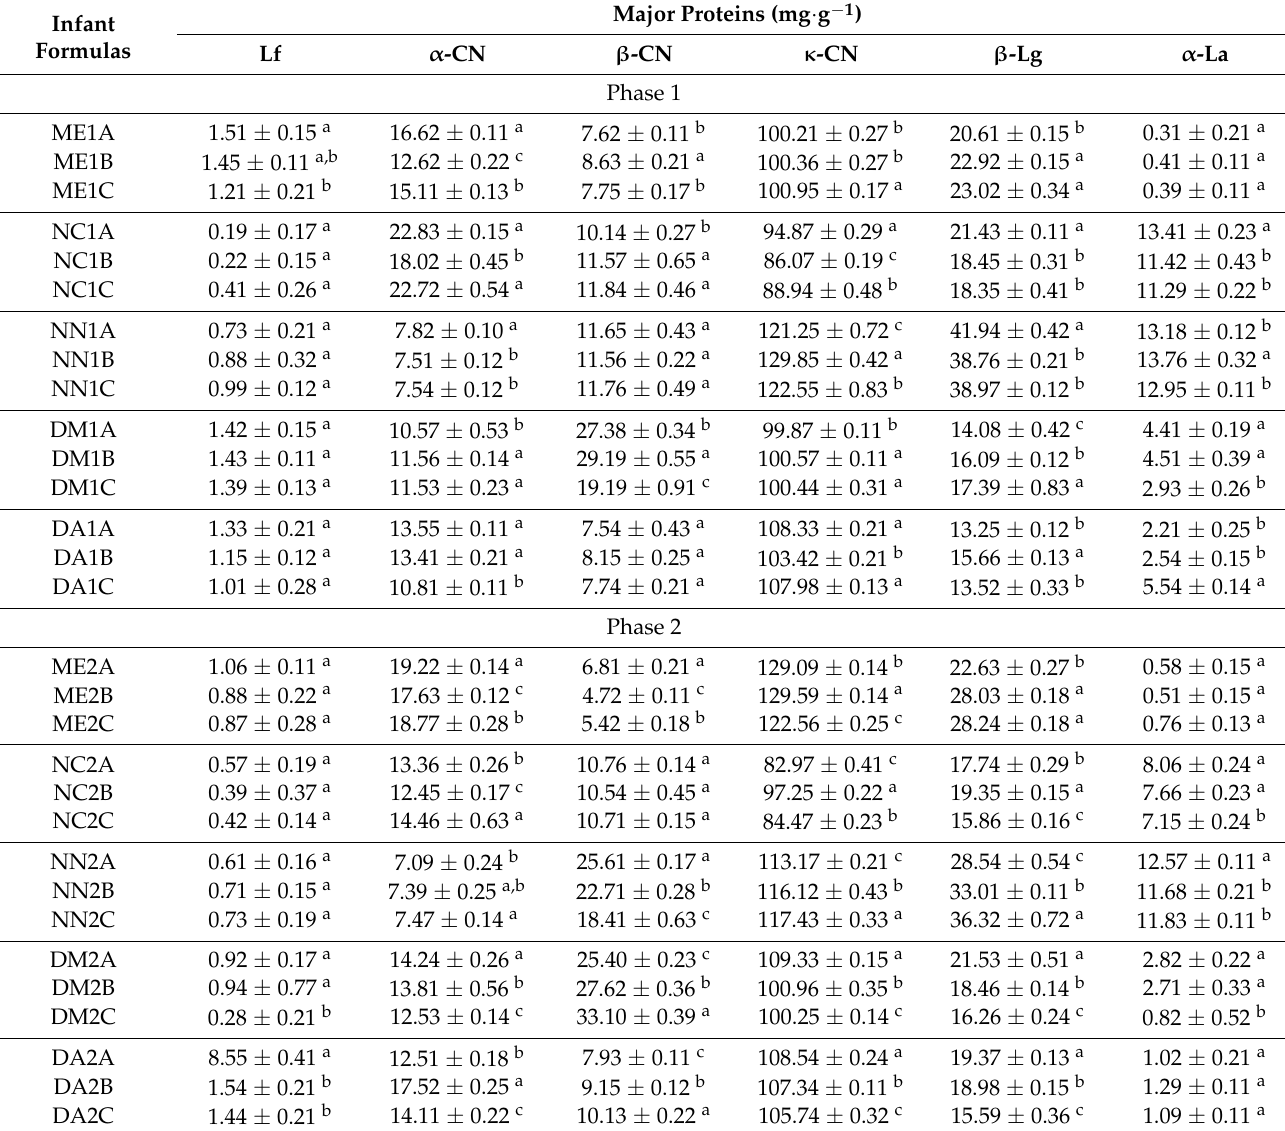
Table 2. Major proteins in phase 1 and phase 2 infant formulas evaluated in three distinct batches from the same manufacturer.